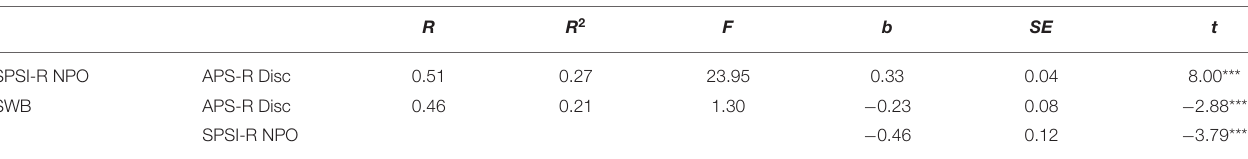
TABLE 3 | The mediation model among APS-R Disc, SPSI-R NPO and SWB ( N = 202). R R 2 F b SE t SPSI-R NPO APS-R